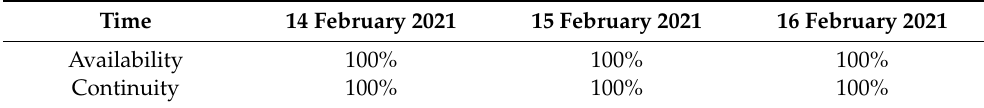
Table 1. The availability and continuity of one-way timing service (normal state).